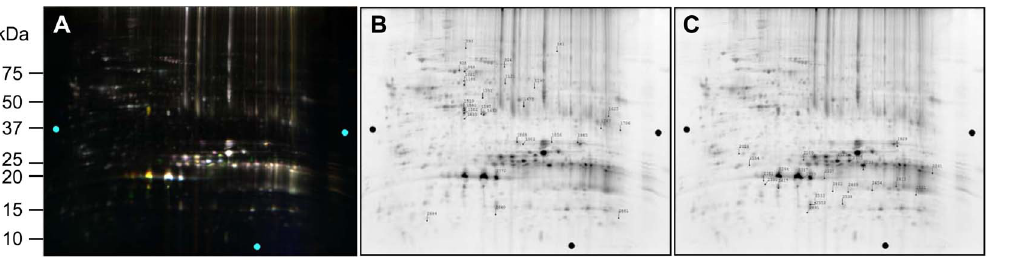
Figure 3. 2D-DIGE analysis of proteomic changes in whole lenses of WT, a A-R49C heterozygous, and a A-R49C homozygous mutant lenses using a pool-based analysis. (A) WT samples were labeled with Cy2, a pool of all samples (containing WT, a A-R49C heterozygous and homozygous proteins) was labeled with Cy3, and the a A-R49C heterozygous mutant sample was labeled with Cy5. The pool sample was a common comparator for each sample. (B, C) Spots that were selected based on analysis of the gels are shown. Quantitative image analysis by biological variation analysis was performed across several samples, and mass spectrometry data for the identified proteins from these gels are listed in Table 3.